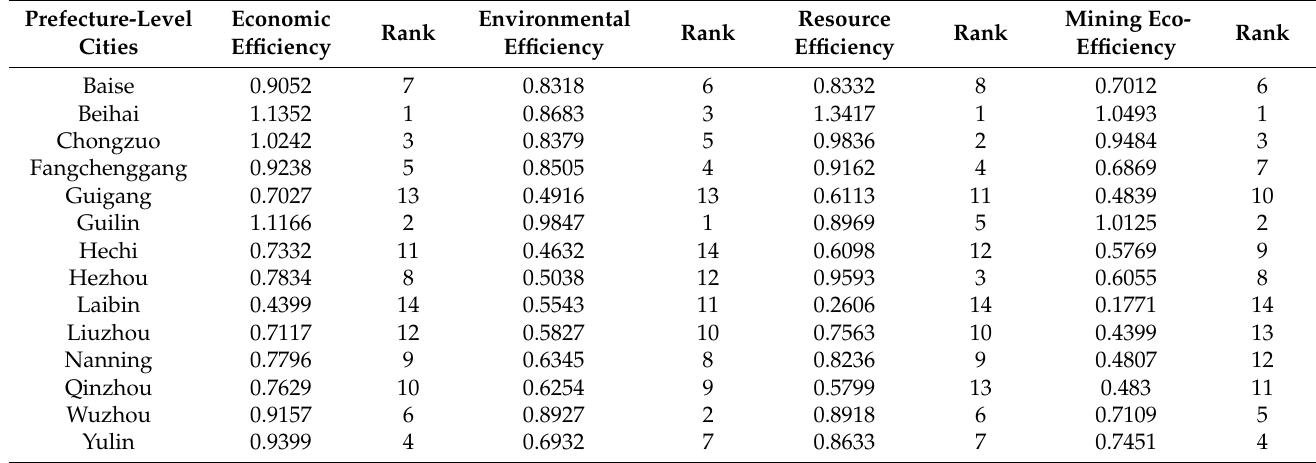
Table 3. The average value and ranking of the eco-efficiency by